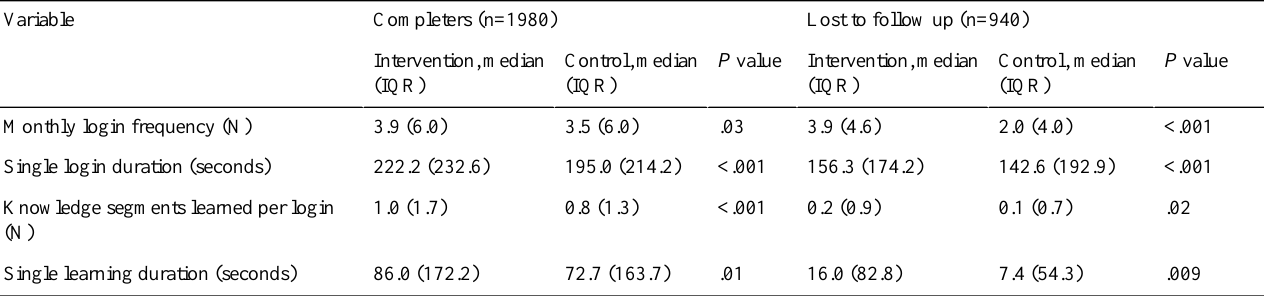
Table 2. Differences in app engagement indicators between the intervention and control groups within 6 months.